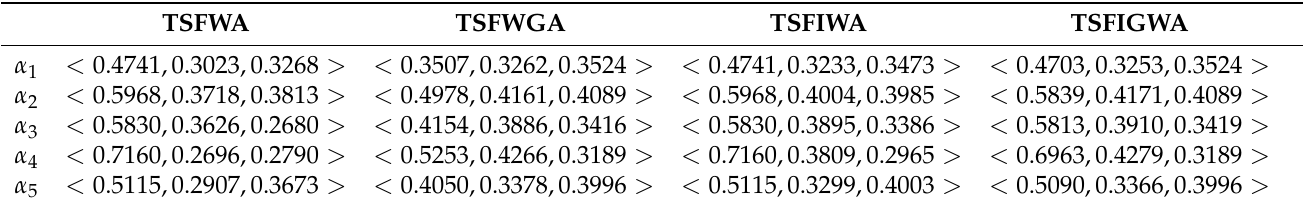
Table 11. Aggregated results of different operators.